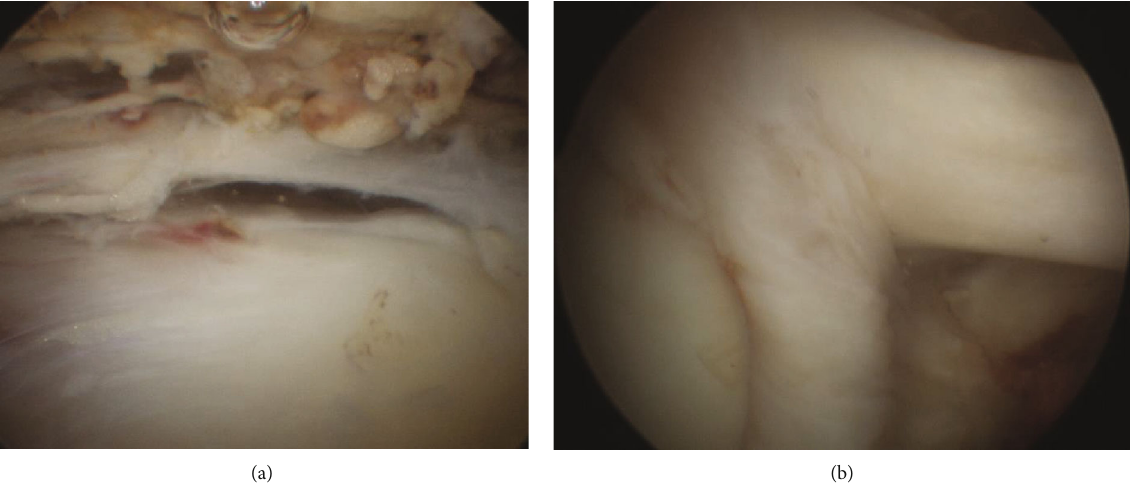
Figure 2: Arthroscopic views of the right shoulder. We can notice the absence of in fl ammatory aspect of the tissues. (a) Subacromial space. (b) Glenohumeral space with the long head of the biceps